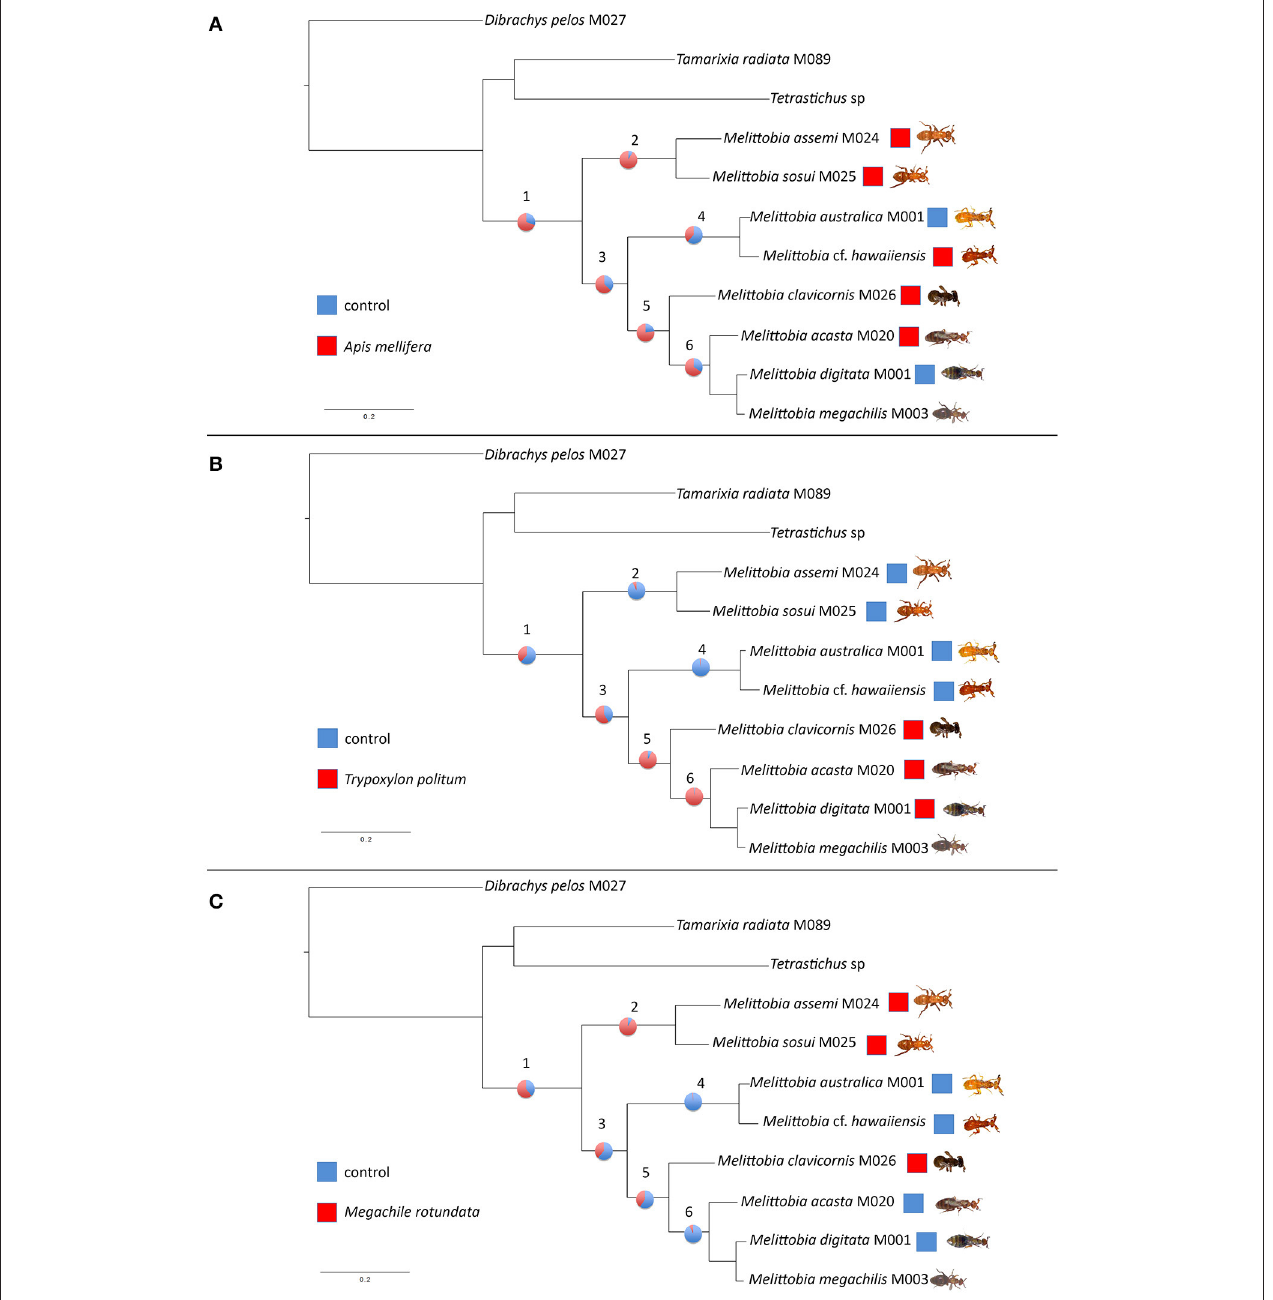
FIGURE 3 | Ancestral character reconstruction. Ancestral state reconstruction for the ancestral host-associated chemical cues exploited by the Melittobia species-group based on the Bayesian approach: (A) Apis mellifera , (B) Trypoxylon politum , and (C) Megachile rotundata . The topology is derived from the ML tree of Figure 2 . Pie charts indicate the relative probabilities at respective nodes (1–6).